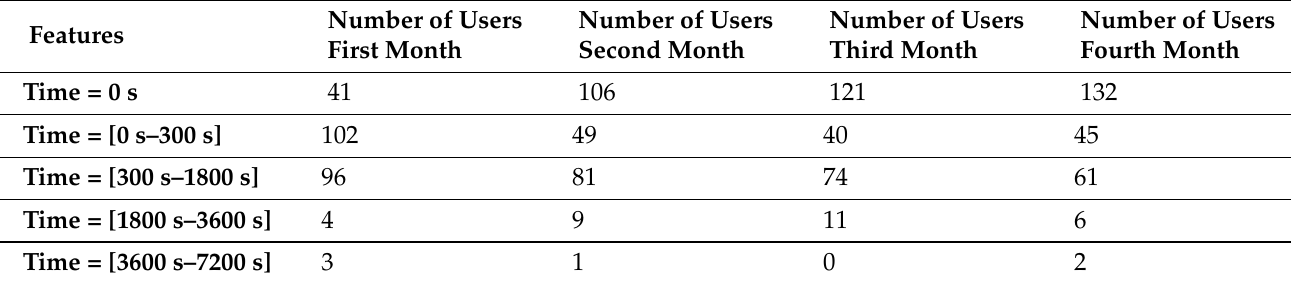
Table 4. Frequency of users in ranges of exercise time per